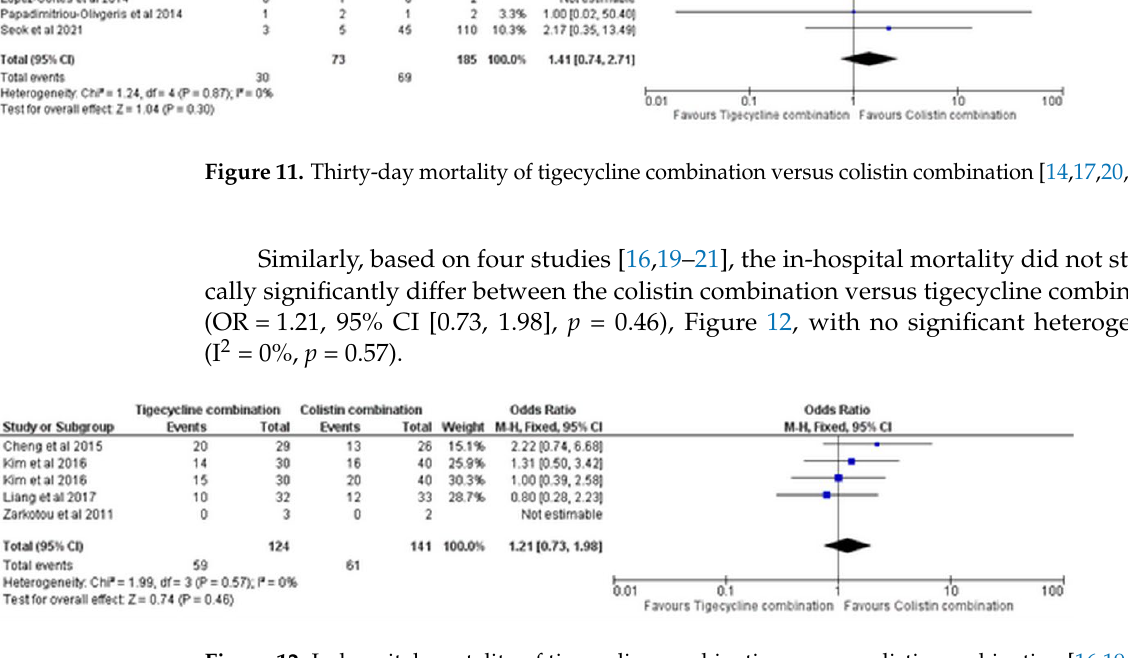
p = 0.62, Figure S1.14, (OR = 1.24, 95% CI [0.13, 11.69], p = 0.85), Figure S1.15, and (OR = 2.89, 95% CI [0.78, 10.75], p = 0.11), Figure S1.16, respectively.